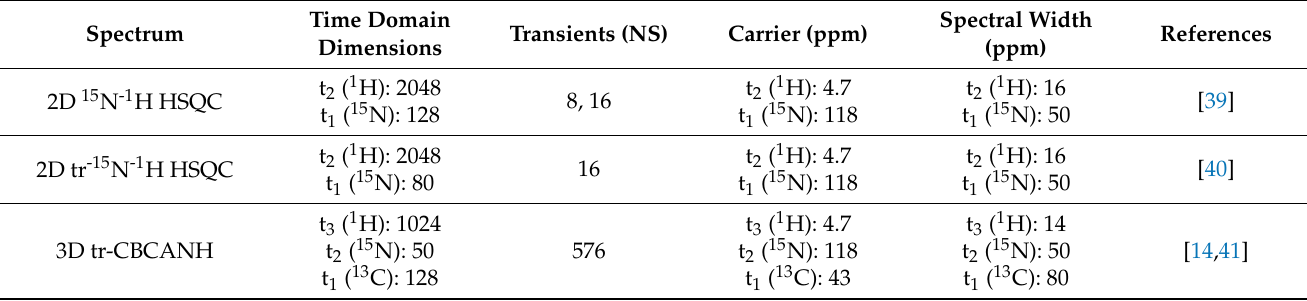
Table 4. List of the collected spectra for backbone and side-chain nuclei assignment of Nb23, with the corresponding acquisition parameters. Experiments denoted with tr indicate the use of TROSY pulse